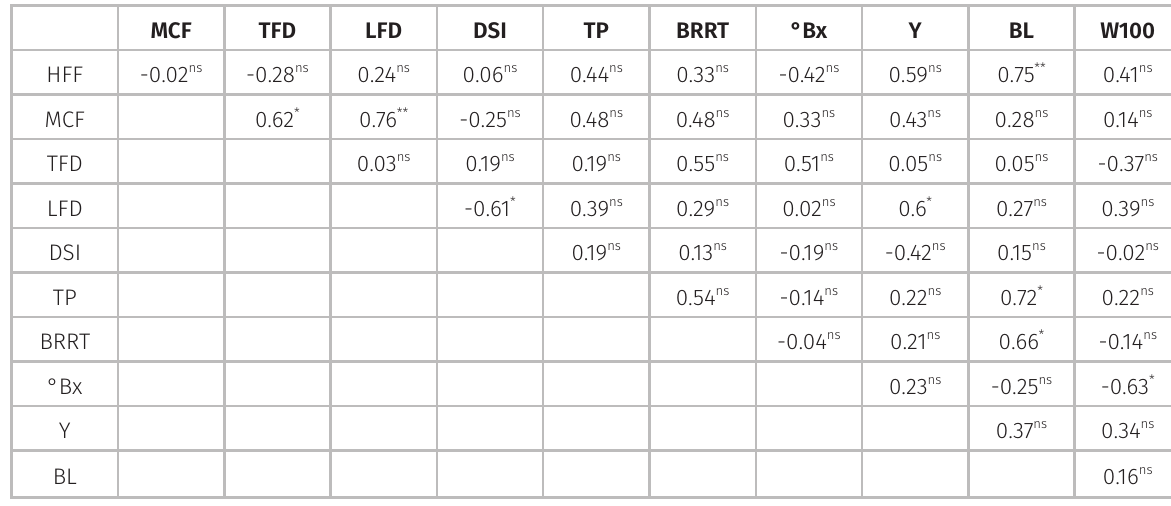
Table III. Pearson correlation coefficients of nine genotypes of C. lanatus var. lanatus plus the commercial cultivars Sugar Baby and Charleston Gray for 11 agronomic traits: number of days until 50% of plants had at least one female flower (HFF), mass of characterized fruit (MCF), the thickness of pericarp (TP), number of days until 50% of plants had at least one male flower (HMF), transverse fruit diameter (TFD), longitudinal fruit diameter of the fruit (LFD), diameter of the stalk insertion (DSI), basal region rind thickness (BRRT), apex region rind thickness